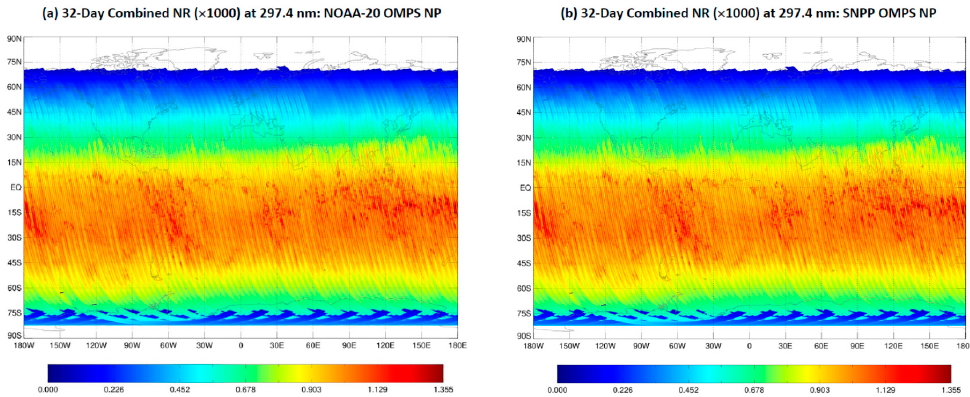
Figure 13. Global distributions of the 32-day-averaged normalized radiance at 298 nm without QC applied for SNPP and NOAA-20 NP. ( a ) NOAA-20. ( b ) SNPP. applied for SNPP and NOAA-20 NP. ( a ) NOAA-20. ( b ) SNPP